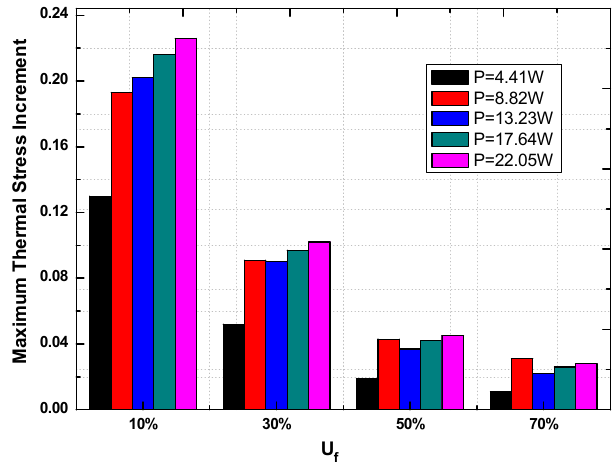
Figure 14. The effect of heating uniformity on the maximum thermal stress of TEG.